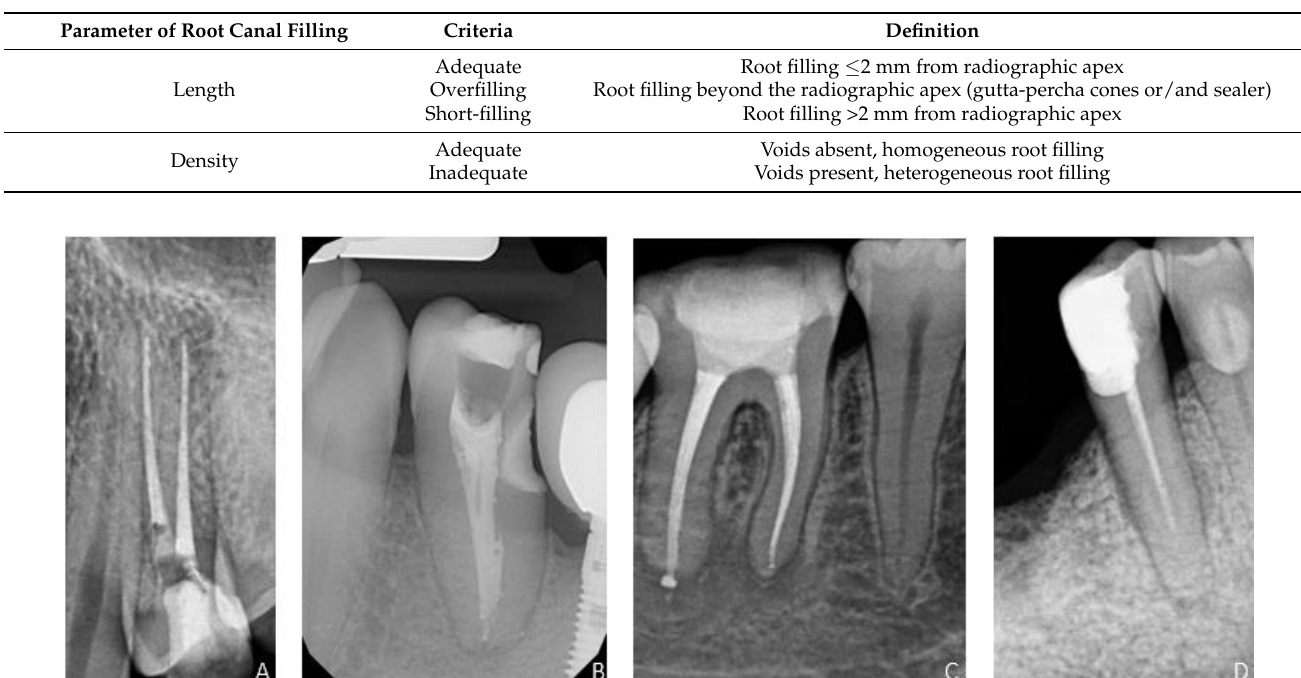
Table 1. Evaluation of parameters of root canal filling.